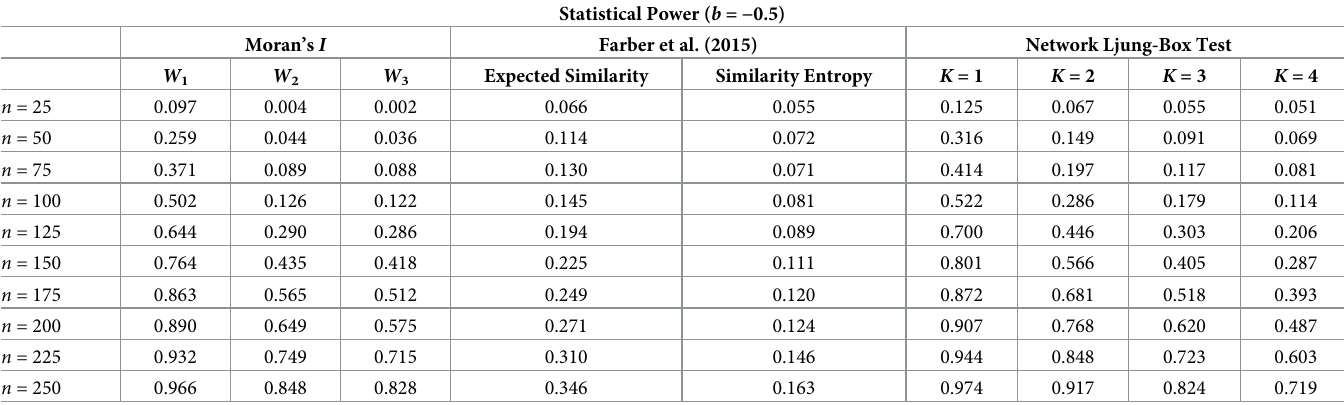
Table 3. Statistical power for negative network autocorrelation. Statistical power of tests for different values of n and K with b = − 0.5. Statistical Power ( b = −